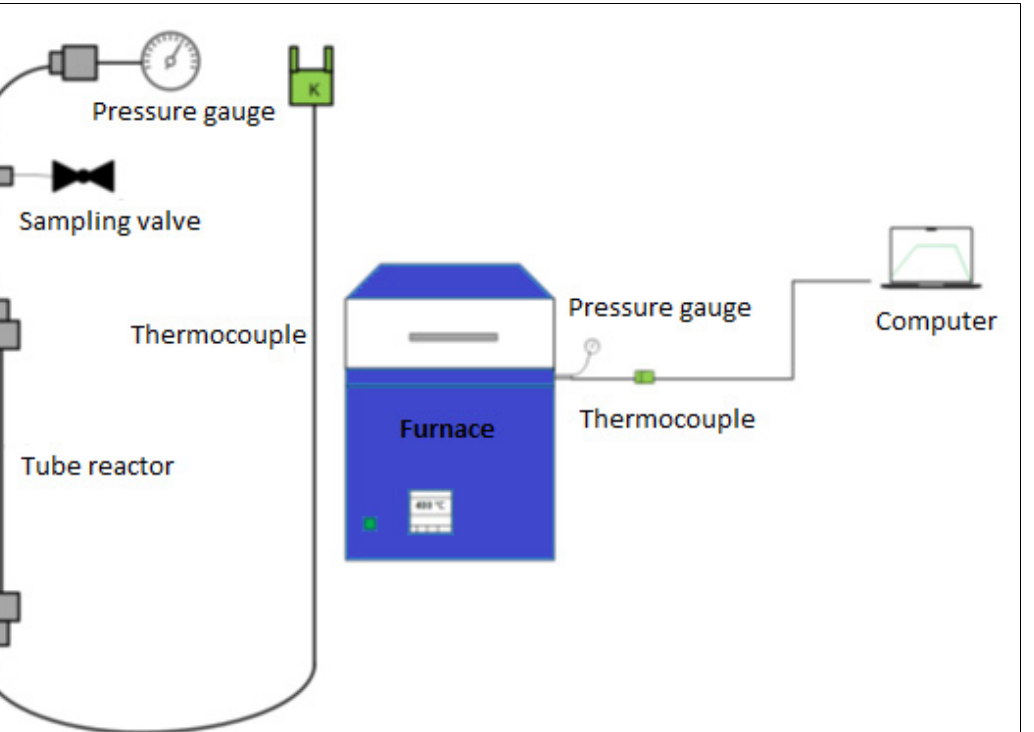
Figure 1. Schematic of the tube reactor and SCWG process.